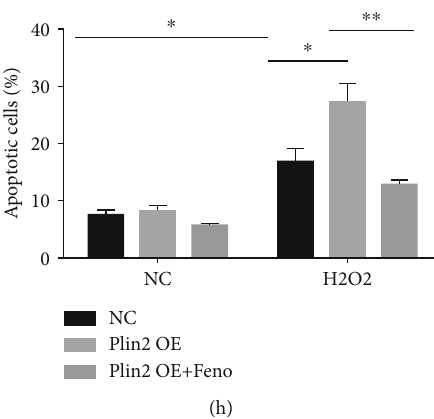
Figure 4: Plin2 impacts apoptosis via the regulation of PPAR α . (a, b) Expression of PPAR α after hydrogen peroxide treatment ( n = 4 ). ∗ P < 0 : 05 vs. 0 μ M hydrogen peroxide; ∗∗ P < 0 : 01 vs. 0 μ M hydrogen peroxide; and ∗∗∗ P < 0 : 001 vs. 0 μ M hydrogen peroxide. (c) Western blot analysis of PPAR α in primary renal proximal tubular cells transfected with Plin2 knockdown plasmids after hydrogen peroxide treatment ( n = 4 ). ∗∗∗ P < 0 : 001 vs. NC; ### P < 0 : 001 vs. hydrogen peroxide. (d, e) Cell viability of Plin2 knockdown or overexpression in primary renal proximal tubular cells after hydrogen peroxide treatment ( n = 4 ). ∗ P < 0 : 05 vs. DMSO NC. (f) Western blot analysis of cleaved caspase-3 expression in primary renal proximal tubular cells transfected with Plin2 overexpression plasmid with or without feno fi brate after hydrogen peroxide (300 μ M) treatment ( n = 4 ), ∗∗ P < 0 : 01 , ∗∗∗ P < 0 : 001 . (g, h) Cell apoptosis in hydrogen peroxide (300 μ M)-treated renal proximal tubular cells transfected with Plin2 knockdown plasmid or control plasmid with or without